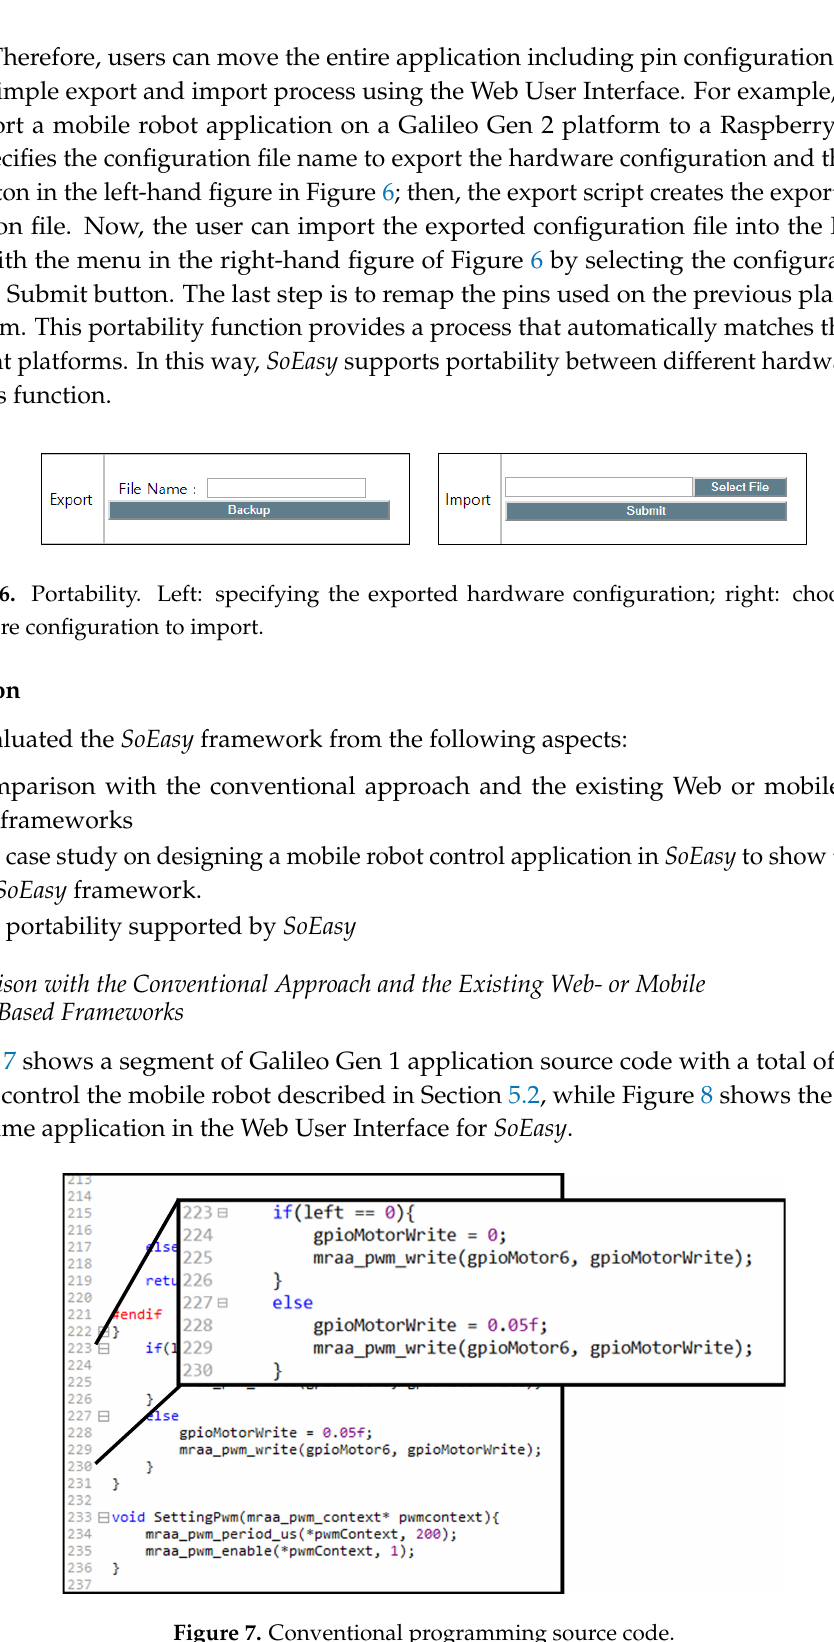
Figure 7. Conventional programming source